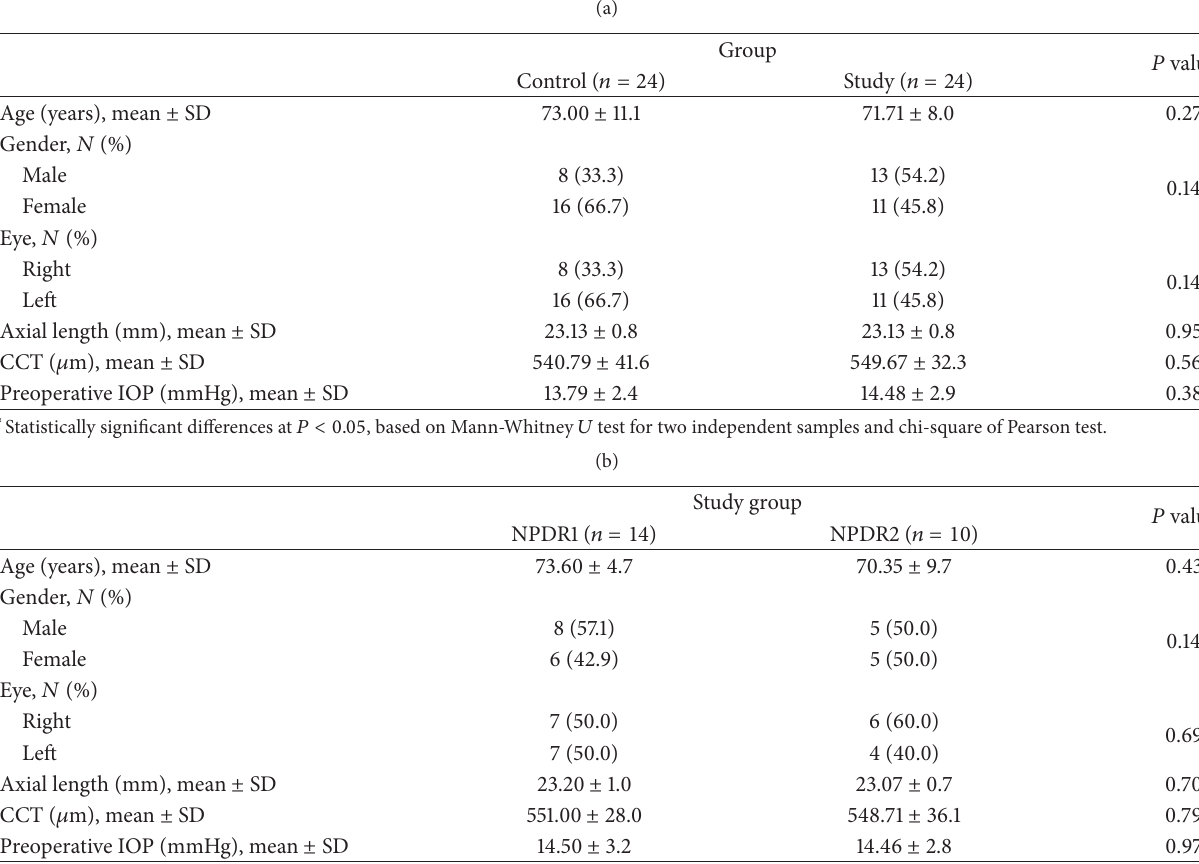
Table 1: Baseline characteristics in NPDR group and control